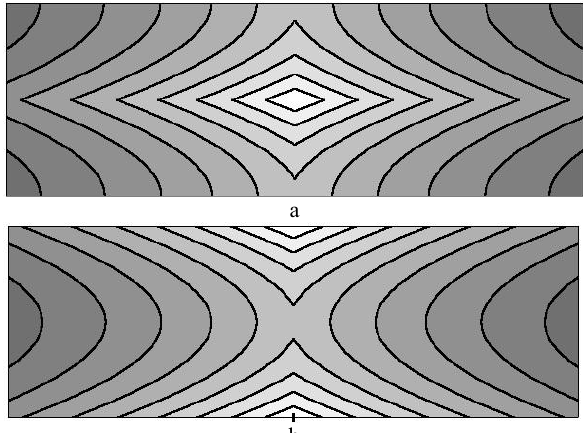
Figure 6. Normalized correlation function of cylindrical image: a) relative to the central pixel, b) relative to the lower border.